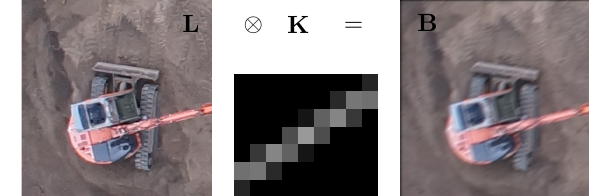
Figure 3: Visual illustration of the blur convolution. At the left the original or pure image ( L ), is convoluted with the blur kernel ( K ). Here the brightness intensity of this matrix is related to value intensity, where the brightest value corresponds to 0 . 1 . The result of the convolution ( B ) is illustrated on the right.